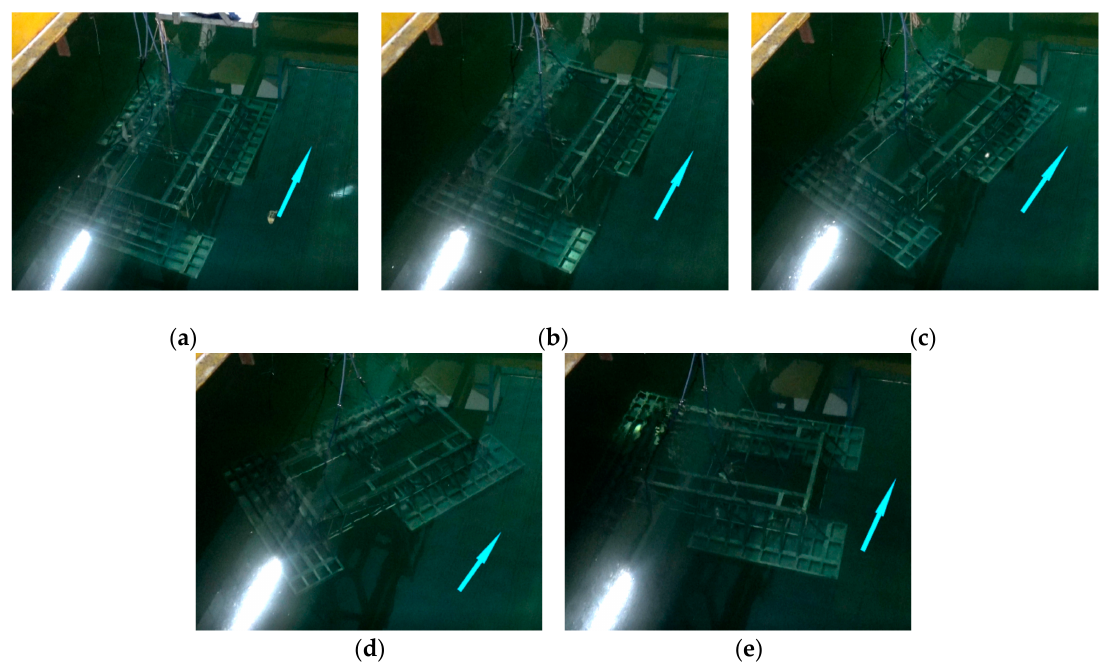
Figure 7. Change in attitude of the model in the towing experiment: ( a ) offset angle is at a maximum, ( b ) offset angle decreasing, ( c ) transitional phase, ( d ) transitional phase, and ( e ) stable.